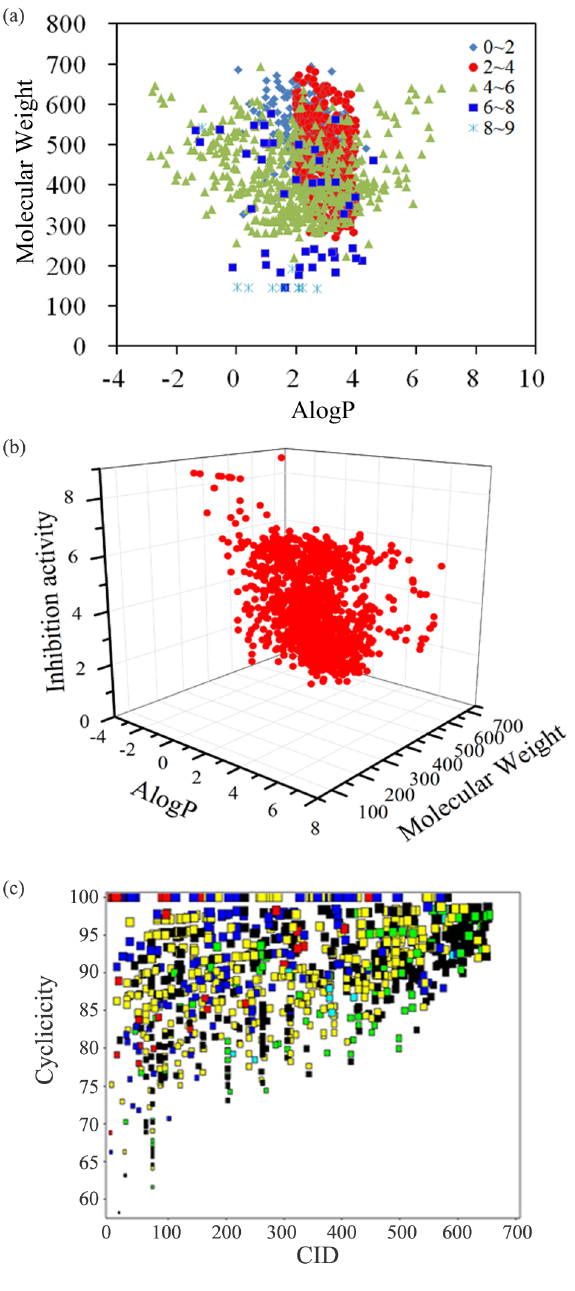
Figure 1. Diversity analysis of the entire data set (n=1264 compounds) with mTOR inhibitory index. (a) Chemical space defined by molecular weight and AlogP. The data are colored according to the chemical mTOR inhibitory index value. (b) Distribution of mTOR inhibitory index in a chemical space defined by MW and AlogP. Both figures are used the same color scheme. (c) The chemical diversity of 1264 compounds was calculated by in-house S-cluster algorithm based on structural features. The color were filled based the number of hydrogen donor of each compound.